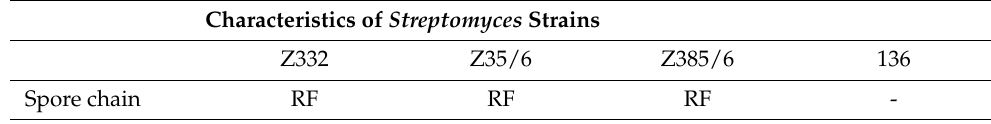
Table 4. Phenotypic characterization of the four selected